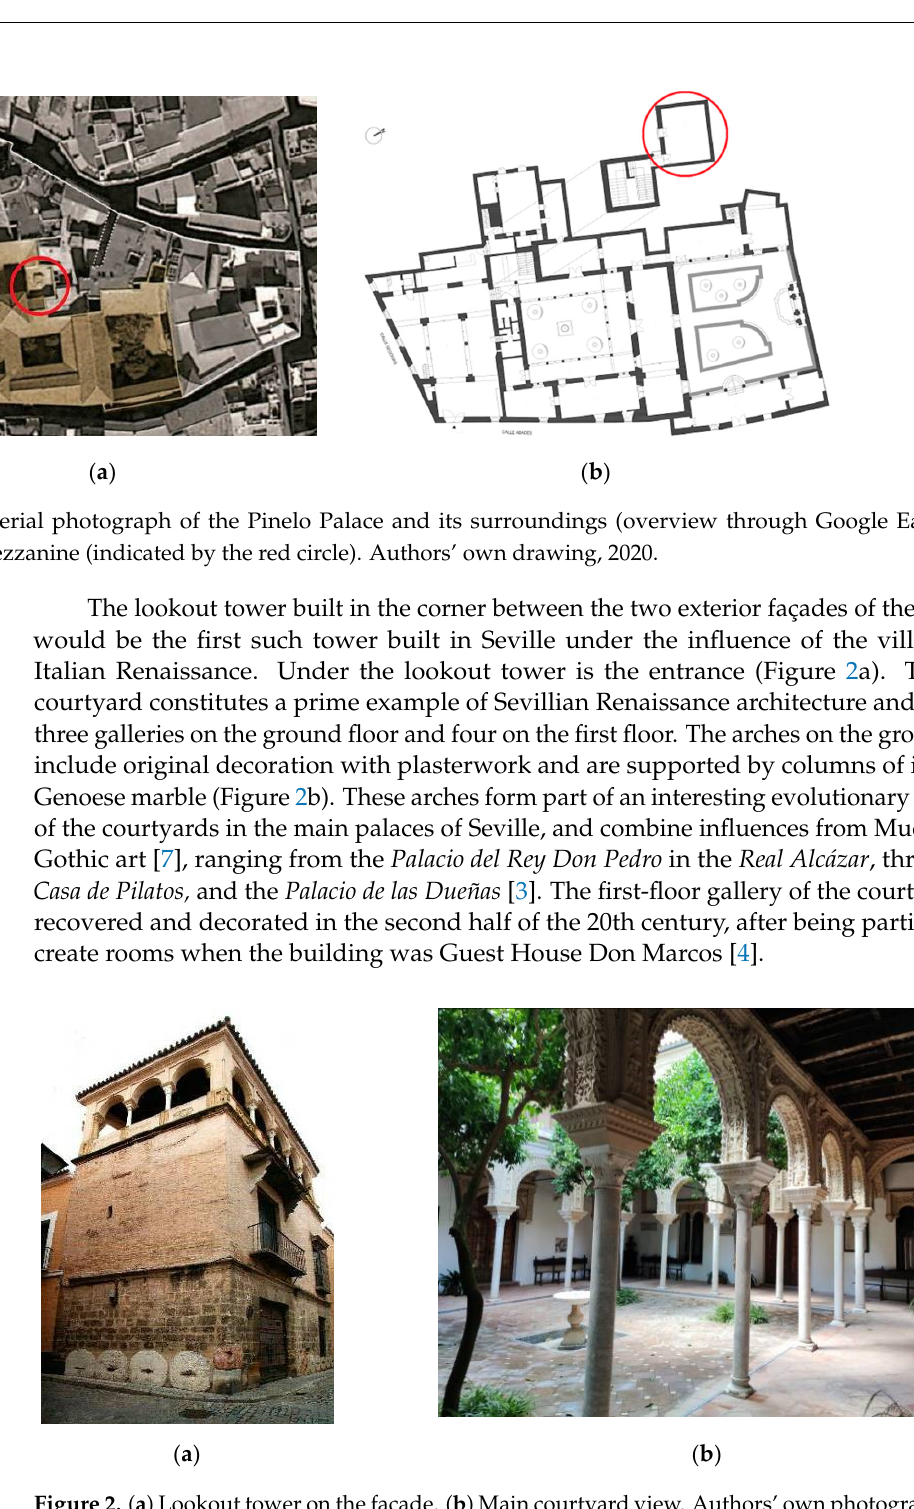
Figure 2. ( a ) Lookout tower on the façade. ( b ) Main courtyard view. Authors’ own photographs, 2020.